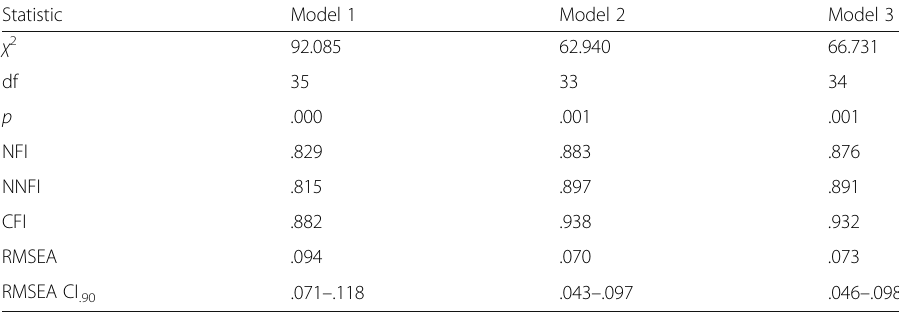
Table 9 Goodness-of-fit summary for CFA